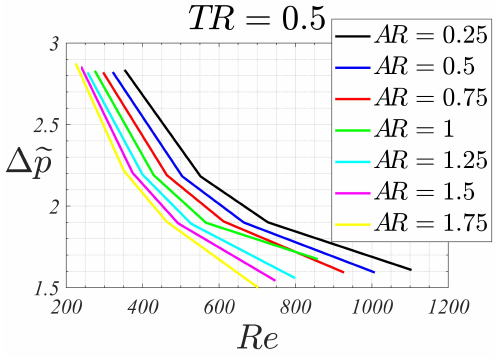
Figure 5. Pressure drop ∆ (cid:101) p vs. Re for different aspect ratios AR , with TR =